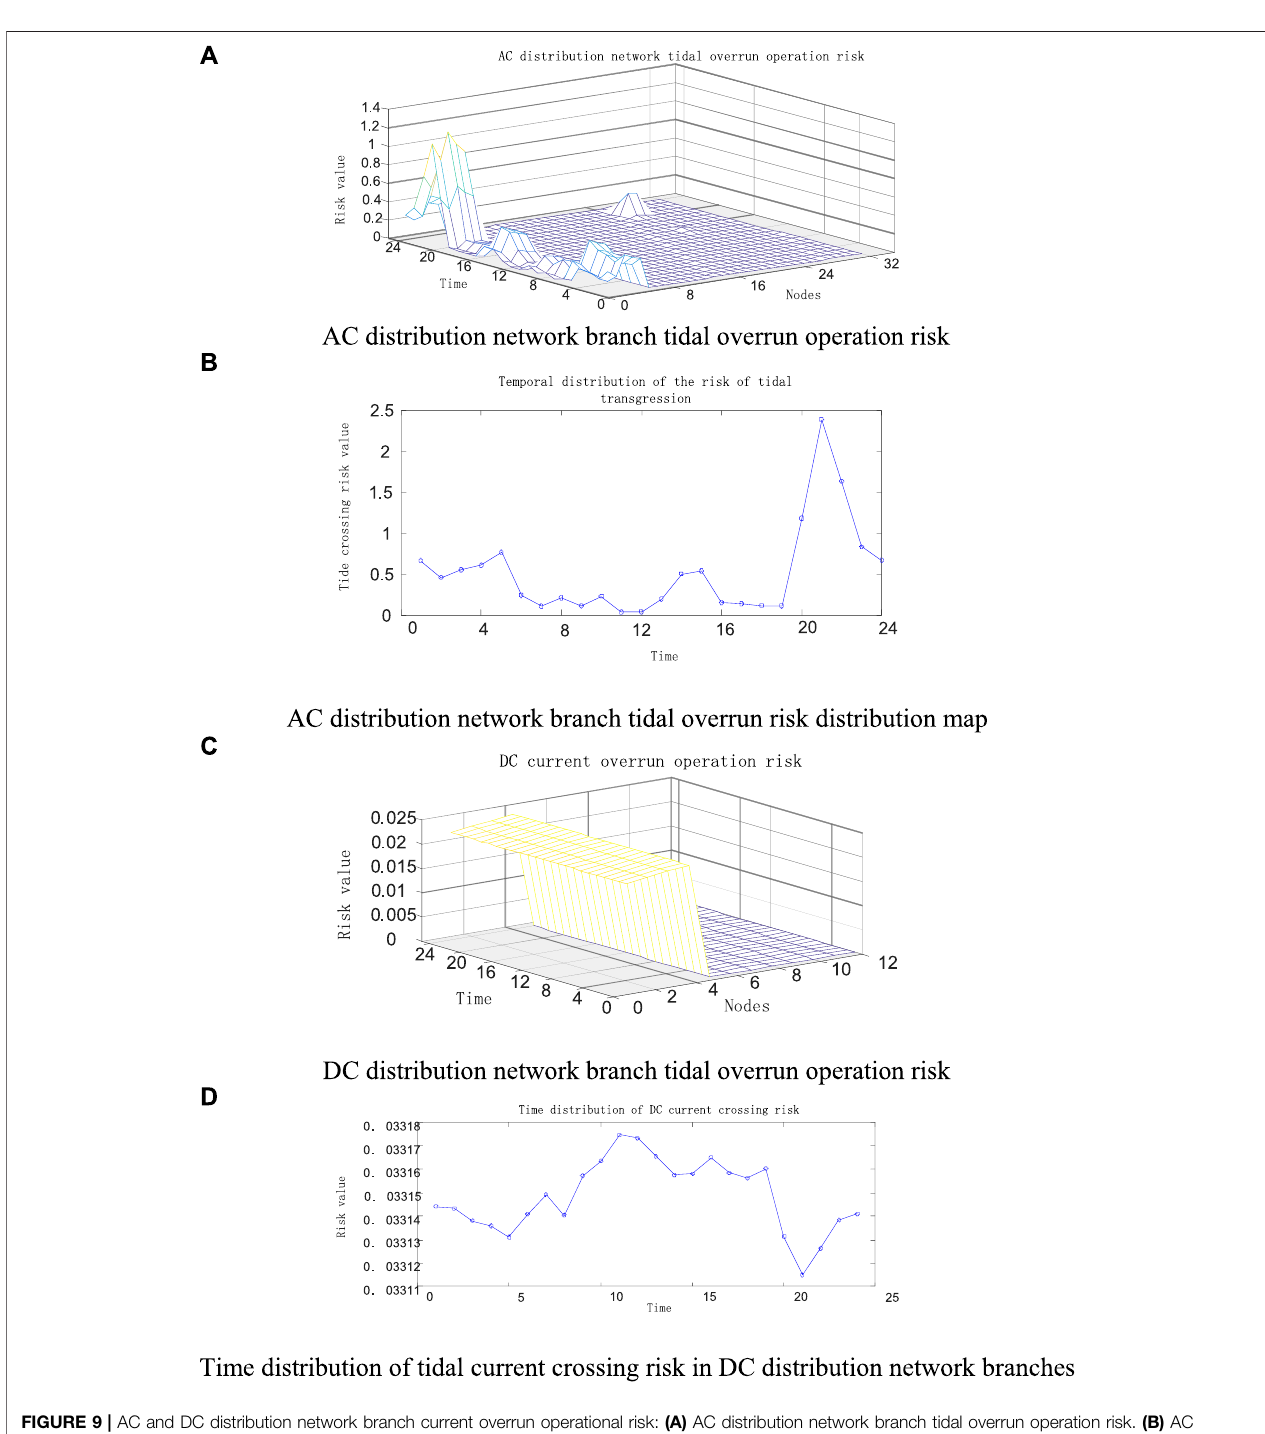
FIGURE 9 | AC and DC distribution network branch current overrun operational risk: (A) AC distribution network branch tidal overrun operation risk. (B) AC distribution network branch tidal overrun risk distribution map. (C) DC distribution network branch tidal overrun operation risk. (D) Time distribution of tidal current crossing risk in DC distribution network